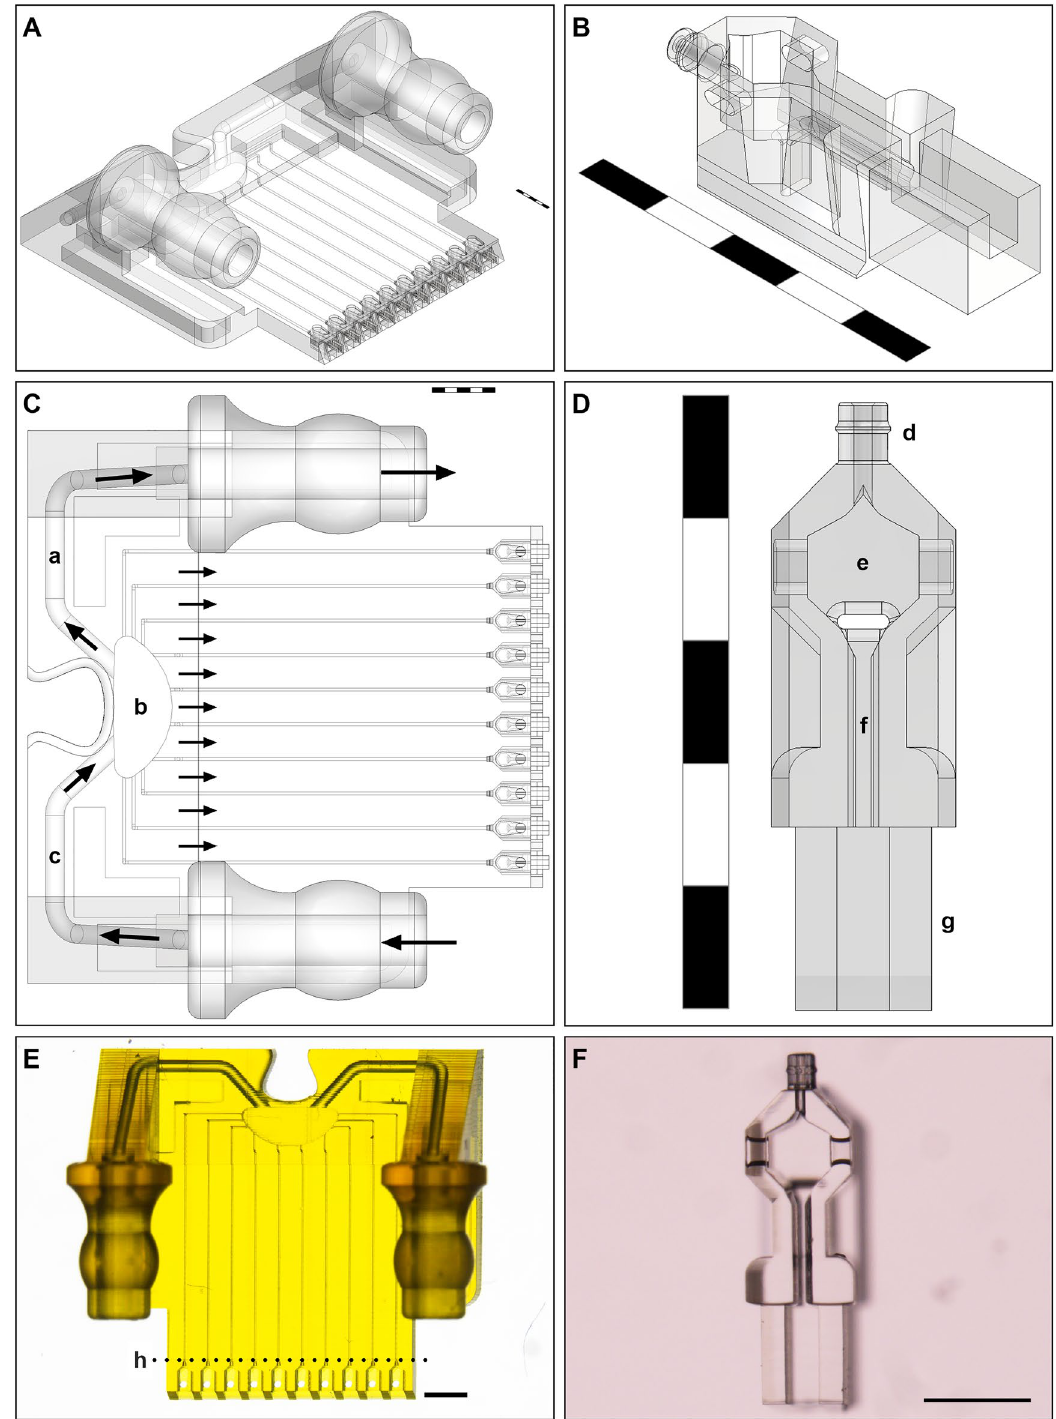
Figure 1. Computer aided design (CAD) models of the nest and cradle (Scale bars A – E = 1 mm; F = 300 µm). ( A ) Isometric view of nest; ( B ) Isometric view of cradle; ( C ) Top view of nest ( a —outlet channel, b —back reservoir, c —inlet channel, arrows indicate direction of fluid flow); ( D ) Top view of cradle ( d —nozzle, e — cell chamber which is open at the top to enable cell manipulation, f —injection channel, g —fin); ( E ) Top image of nest at 1 × magnification on Nikon SMZ18 stereomicroscope. The dimensions of the nest ‘chip’ are 8.8 mm × 8.2 mm × 3.6 mm (nest printed at 10 × in adaptive resolution in course mode above line h and fine mode below line h ); ( F ) Top image of cradle at 8 × magnification with a Nikon SMZ18 stereomicroscope (cradles printed at 20 × in course infill